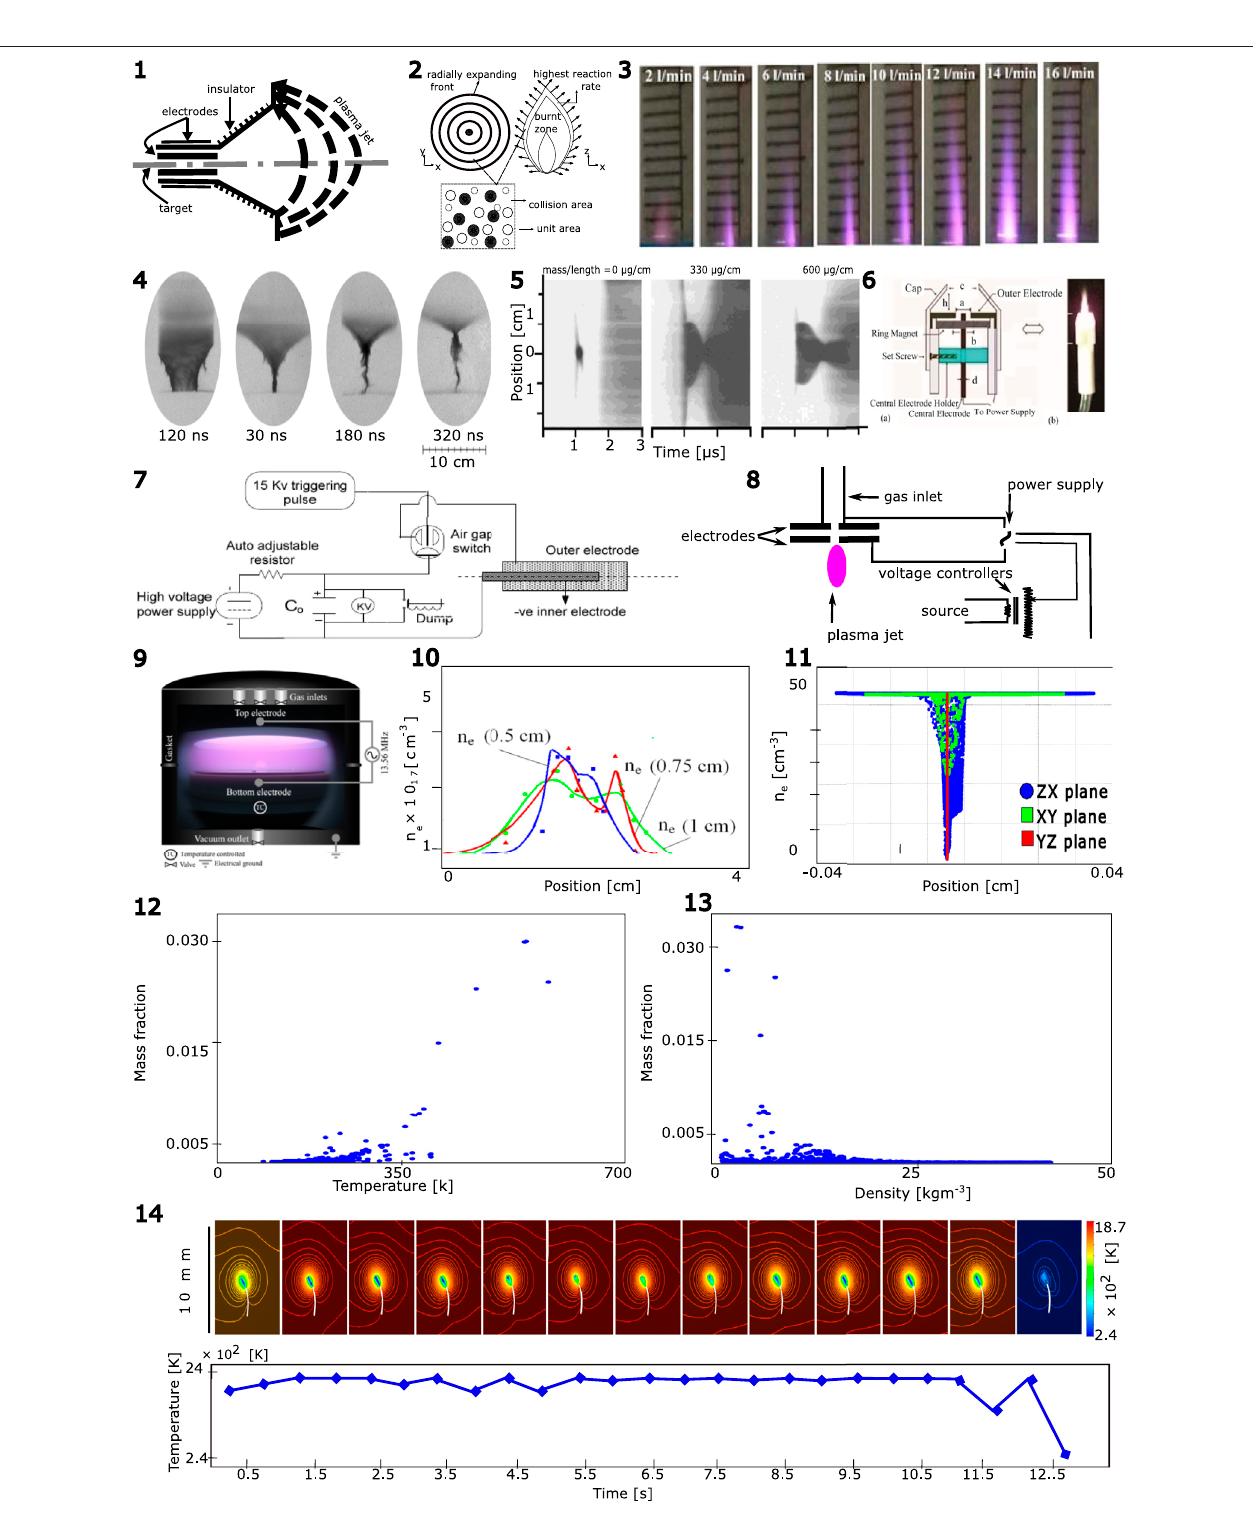
FIGURE2|(1) Principleofplasmajetgeneration. (2) Principleofcandle fl ame. (3) Plasmalengthvariationwithdifferentinlet fl owrates[adapted from(Lotfy(2017)]. (4) Plasma discharges in pure neon [adapted from Auluck et al. (2021)]. (5) The effect of liners in plasma-focusing device (PF) discharge [adapted from Auluck et al. (2021)]. (6) An air plasma generation setup [adapted from Kuo (2012)]. (7) Circuit design of a 1.5-kJ coaxial plasma device [adapted from Allam et al. (2011)]. (8) Electric circuit of nitrogen-plasma jet device [adapted from Lotfy (2017)]. (9) , Real-time plasma from an RIE setup [adapted from Ghosh (2016)]. (10) Electron density pro fi les at three different distances from the anode plane [adapted from Auluck et al. (2021)]. (11) FEM-simulated electron density vs position of candle fl ame. (12) Temperature-dependent oxygen mass fraction simulation in candle fl ame. (13) Oxygen mass fraction vs density in candle plasma. (14) Time-dependent temperature distribution over area of a candle plasma.